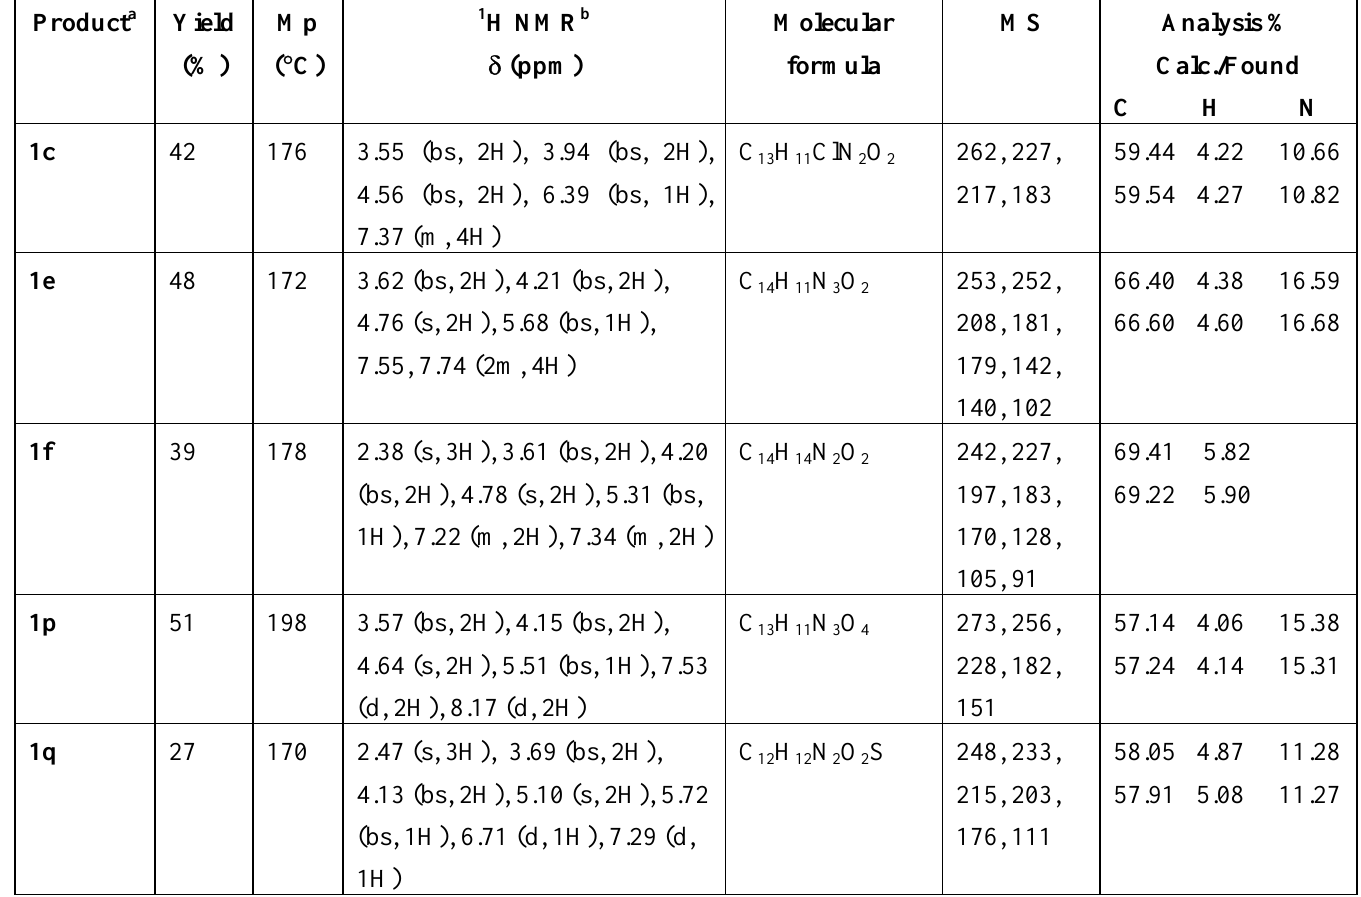
Table 3: 1 H-NMR, MS and analytical data of 1c,e,f,p and